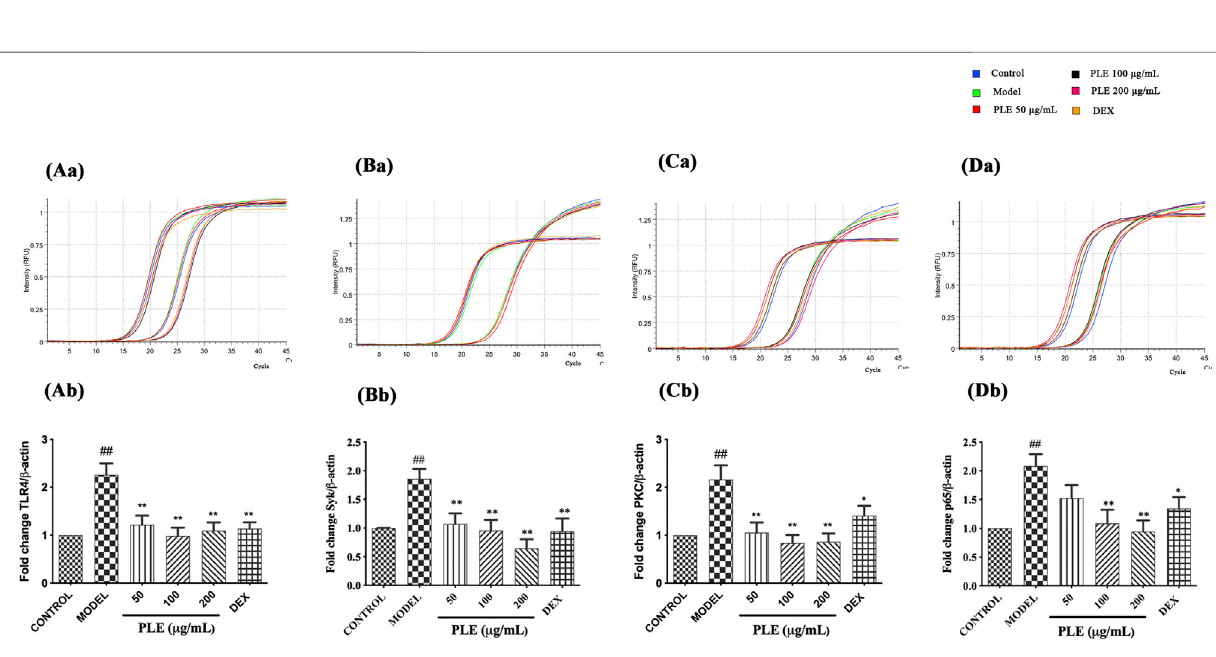
Frontiers in Pharmacology |